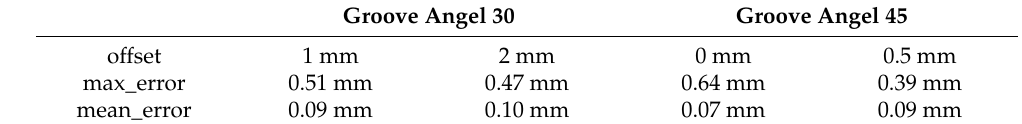
Table 3. Errors of prediction.